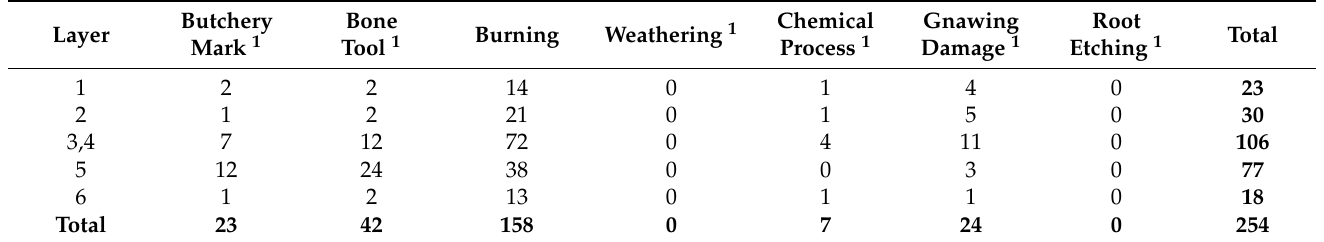
Table 5. Taphonomic evidence in Area 3 of the Ban Rai Rockshelter, in numbers of